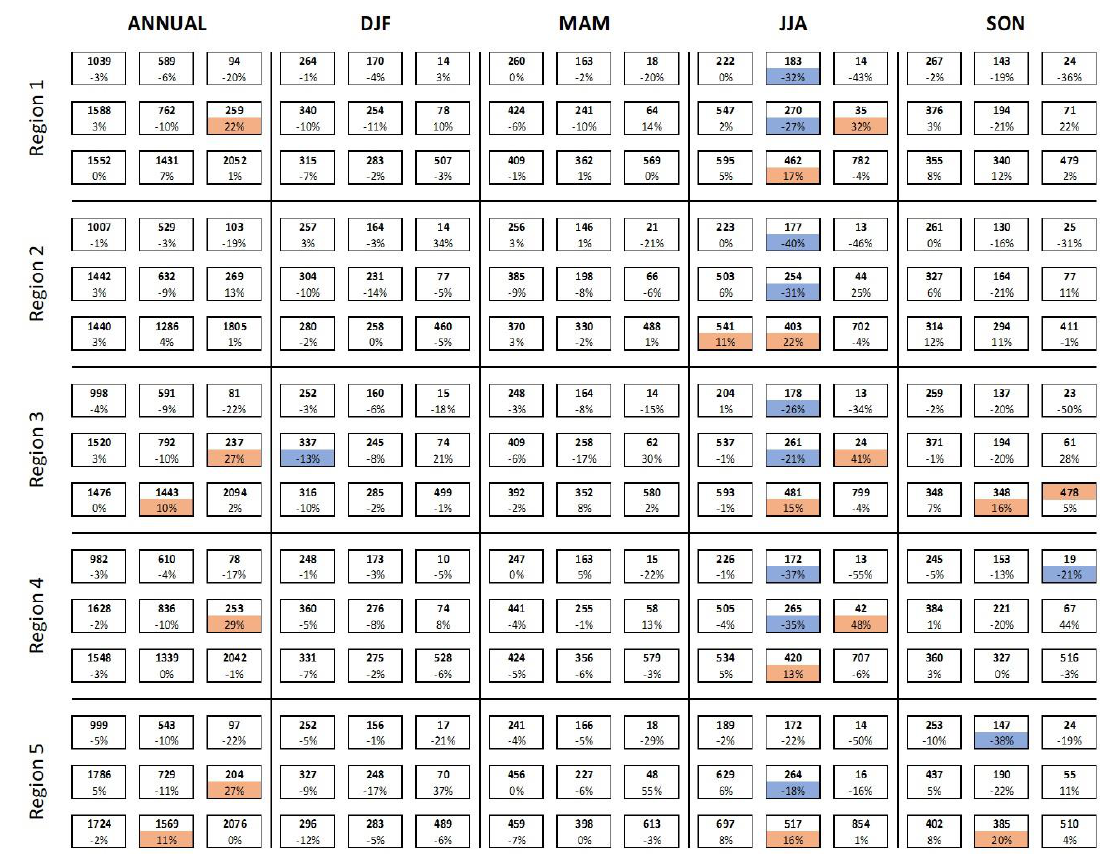
Figure 19. The number of wind speed events at 850 hPa for each type of event, region and season. For the historical climate (1st line of the cell) and the difference between the future and historical (2nd line of the cell). Shaded values indicate significant differences (t-student 5%) positive (red) and negative (blue).